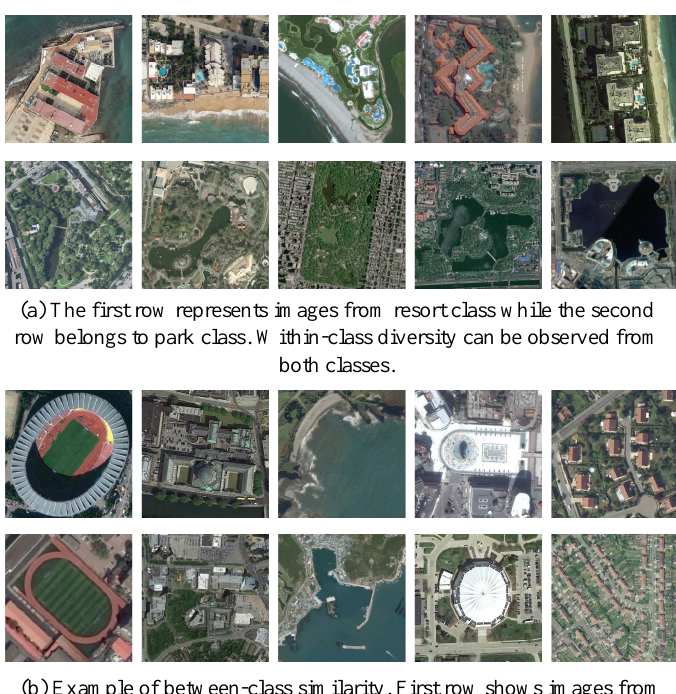
Figure 1. The challenging scene images of AID dataset [6]. ( a ) The intra-class diversity and ( b ) inter- class similarity are the main obstacles that limit the scene classification